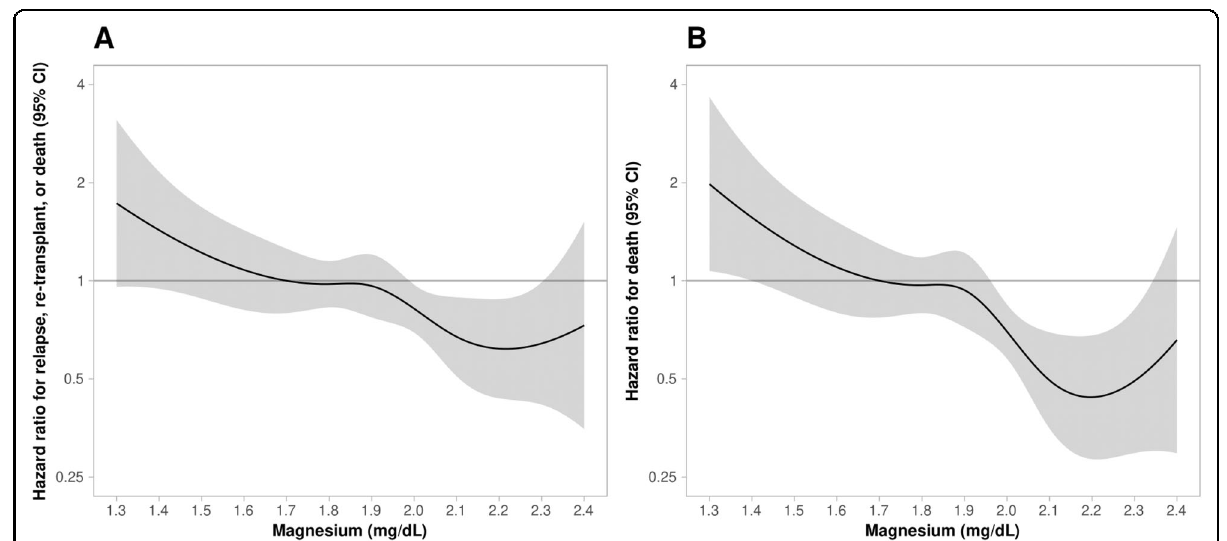
Fig. 4 Hazard of death estimated as a function of magnesium level. Log-scale hazard of A event-free survival and B overall survival up to 1 year following transplant by serum magnesium (mg/dL) drawn prior to myeloablative conditioning. The shaded areas represent the con fi dence